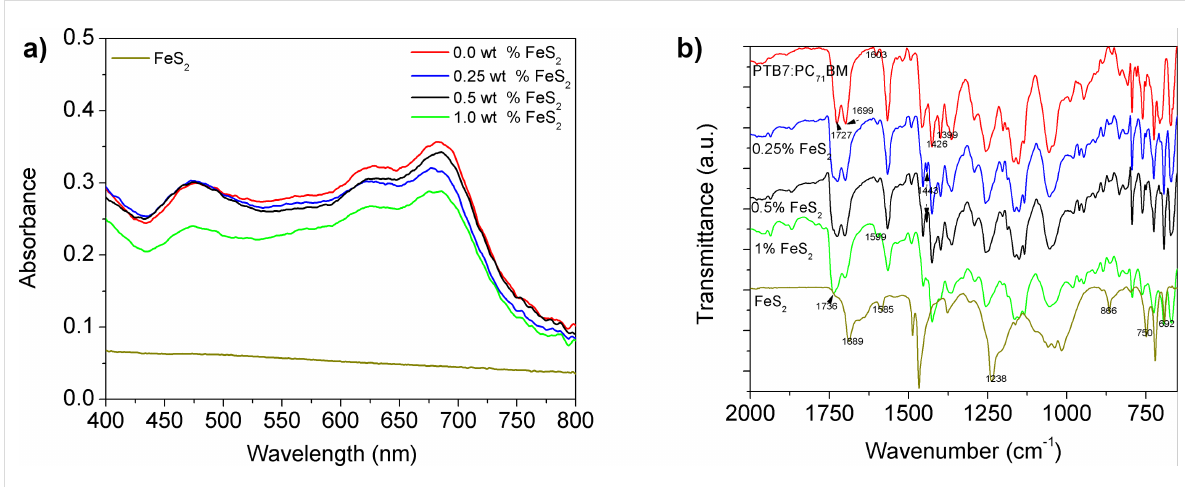
Figure 5: a) UV–vis absorption and b) FTIR spectra of the blend PTB7:PC 71 BM at different FeS 2 concentrations: 0.0, 0.25, 0.5 and 1.0 wt %.